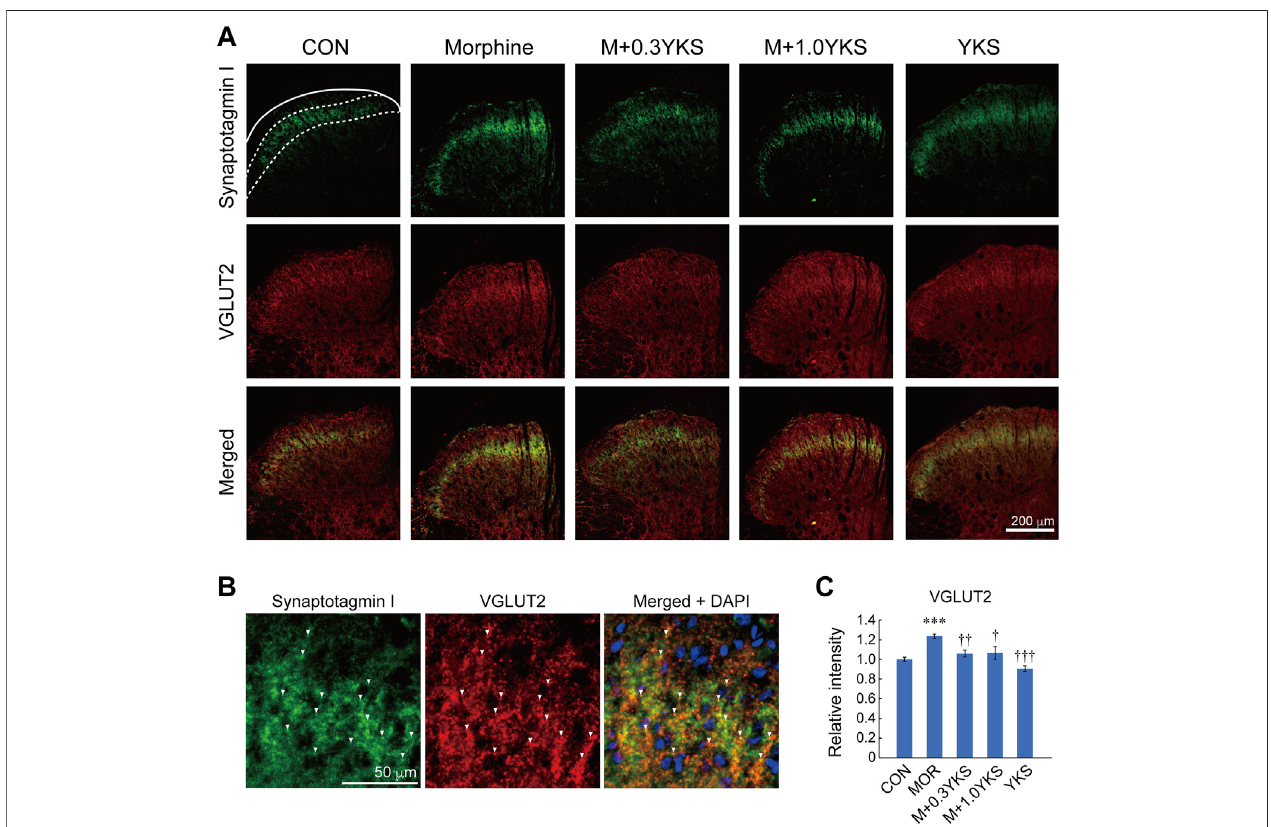
FIGURE 5 | Morphine increased the expression of VGLUT2 in lamina II of the spinal cord dorsal horn, which was inhibited by YKS. (A) Immunostaining images for synaptotagmin I and VGLUT2 in the dorsal horn. Green: synaptotagmin I; Red: VGLUT2. White bar = 200 μ m. (B) Magni fi ed images for synaptotagmin I and VGLUT2 in lamina II. Green: synaptotagmin I; Red: VGLUT2. White bar = 50 μ m. White arrow heads indicate the representative synaptotagmin I-positive presynaptic terminals that expressed VGLUT2. (C) Quanti fi ed data for VGLUT2 in the synaptotagmin I-expressing region. The mean immunoreactivity of VGLUT2 in each section was determined inthe synaptotagmin I-expressing lamina IIregion [The areabounded bytwodashed and solid linein (A)]. Thespinal cord sections wereobtained from three rats in each group. The number of (sections and dorsal horns) determined in this experiment were: CON (18 and 36); Morphine (18 and 36); M+0.3YKS (19 and 38); M+1.0YKS (13 and 24); YKS (20 and 40). *** p < 0.001 vs.CON group; † p < 0.05, †† p < 0.01, ††† p < 0.001 vs. Morphine group.